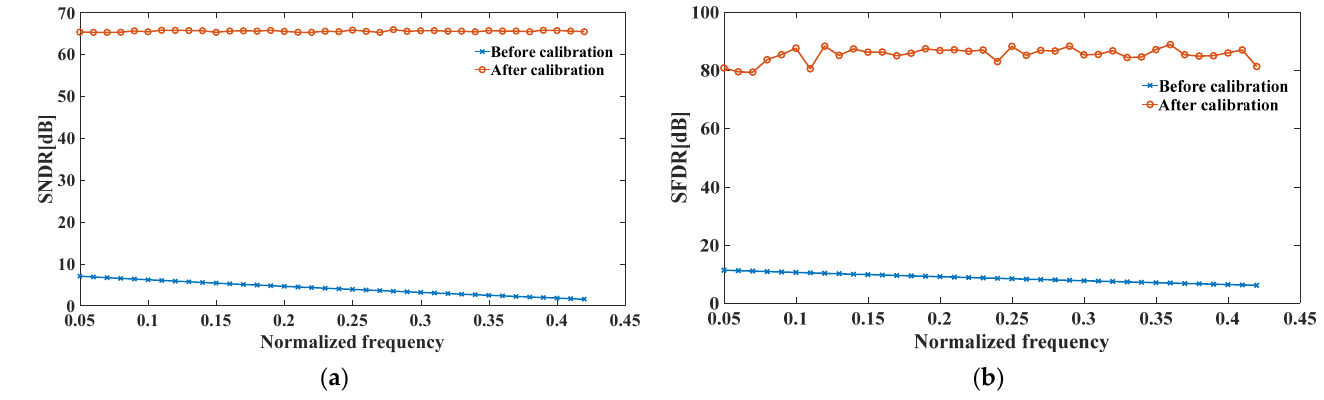
Figure 8. Performances of the proposed method in the second Nyquist bandwidth of the sub ‐ ADC. ( a ) The SNDR of TI ‐ ADCs with different frequencies; ( b ) the SFDR of TI ‐ ADC with different frequencies.